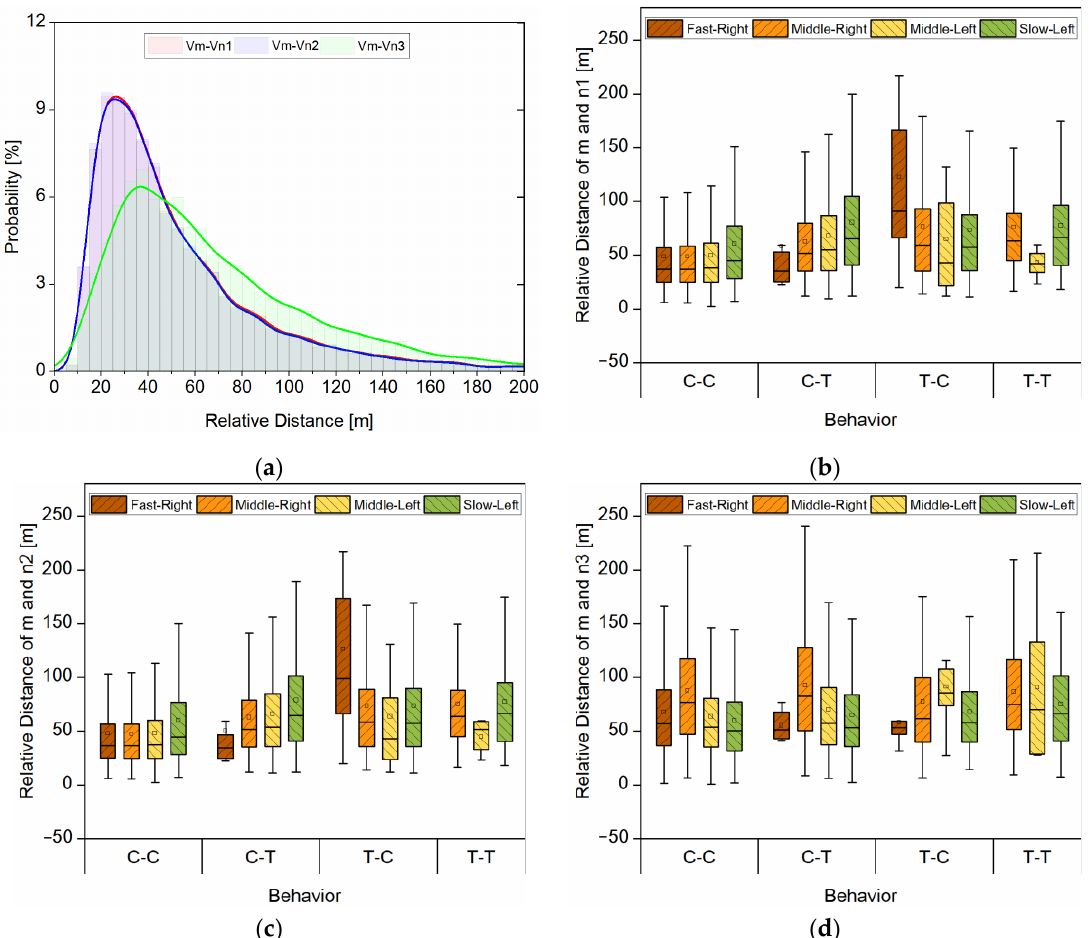
Figure 6. ( a ) Probability distribution of ∆V; ( b ) ∆V between m and n1; ( c ) ∆V between m and n2; ( d ) ∆V between m and n3.